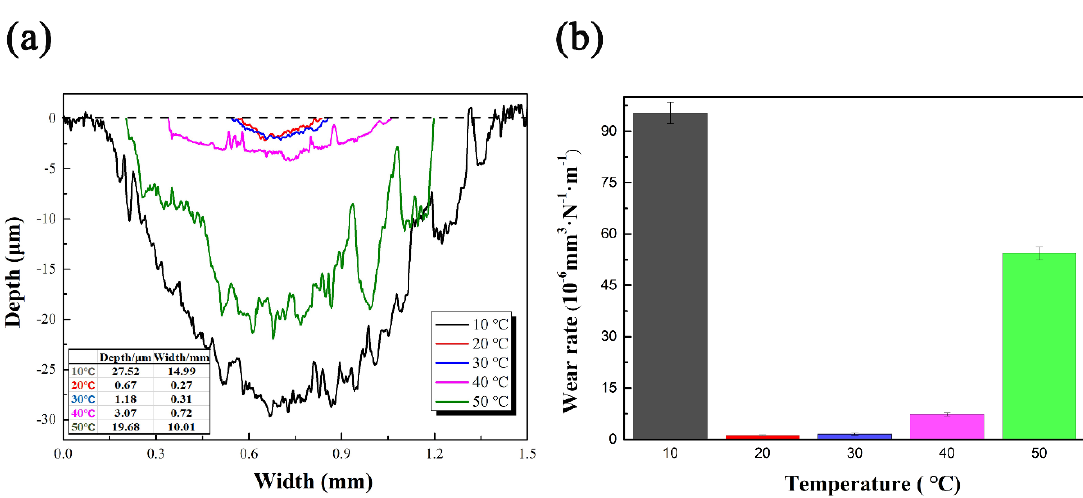
Figure 11. ( a ) Cross-section of wear tracks and ( b ) wear rates of composite anodic films fabricated at different temperatures.